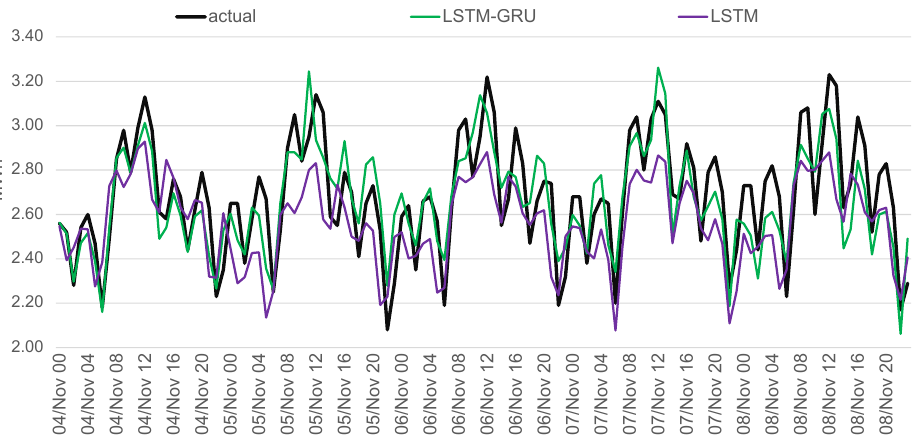
Figure 8. Comparison between the actual and the forecasted values with GRU. LSTM-GRU network improves the overall errors, because of the GRU layer, but there is a clear pattern of high variations for peak values and off-peak period. The authors in [47] could find a clear difference between LSTM and GRU, and suggest that the selection of the type of gated recurrent unit depend on the dataset and corresponding task. In our case, with industrial load forecasting, the results are clearly in favor of GRU.